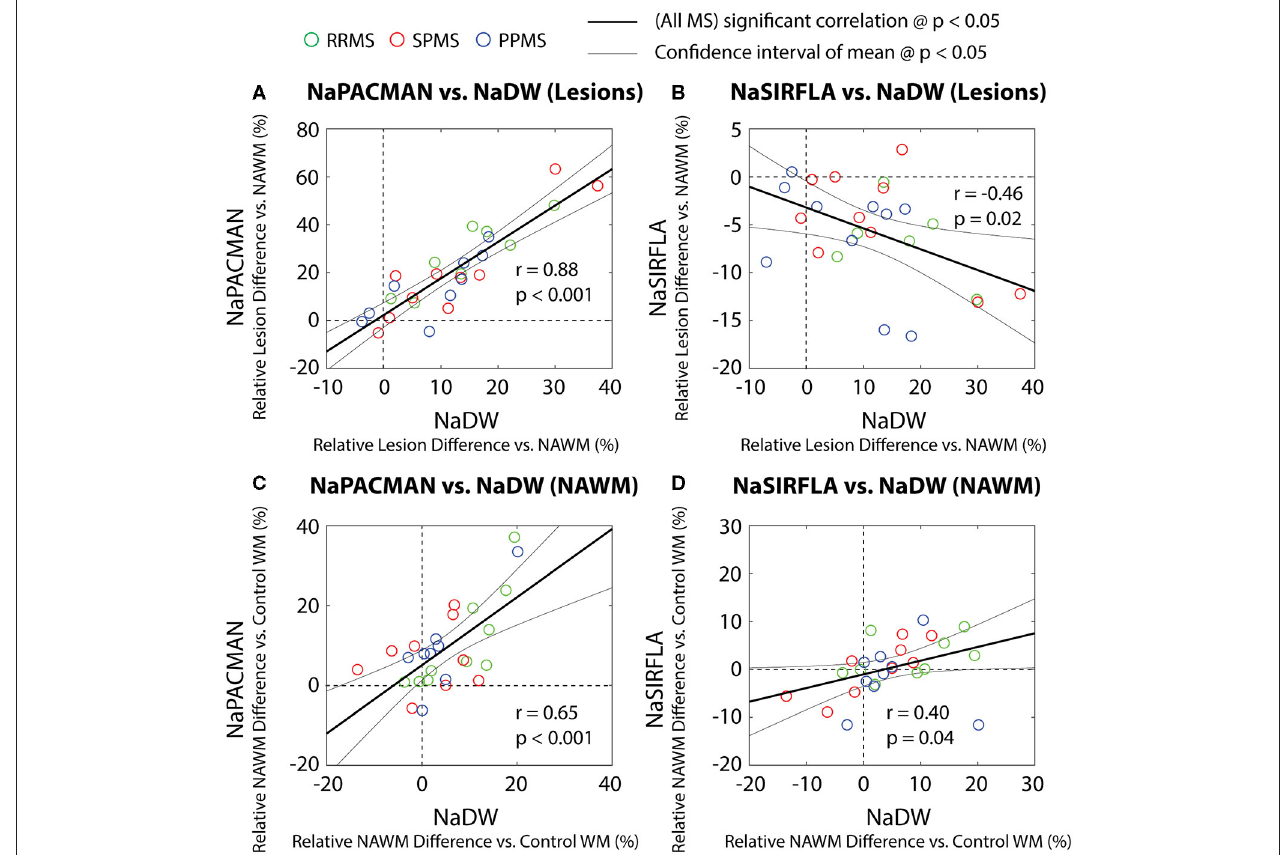
FIGURE 5 | Relaxation-weighted sequence correlations with NaDW (or TSC) for relative lesion intensity difference from directly comparably NAWM (in the same MS patient and WM region) (A,B) and relative NAWM difference from average control WM (C,D) for all 30MS participants (one symbol per patient). (A) Lesion intensity increase over directly comparable NAWM is positively correlated between NaPACMAN and NaDW with slope = 1.52 ± 0.33 showing a greater change for NaPACMAN. (B) However, lesion vs. NAWM is negatively correlated between NaSIRFLA and NaDW with slope = − 0.22 ± 0.18 (i.e., the more sodium TSC in lesions, the greater the signal loss on NaSIRFLA) and significant intercept offset of − 0.03 ± 0.03 ( p = 0.02). Note that for (A) the y-axis is 2 × the x-axis, while in (B) the y-axis is 0.5 × the x-axis. (C) NAWM intensity relative to average control WM is positively correlated between NaPACMAN and NaDW with slope = 0.85 ± 0.41 (less steep than lesions vs. NAWM) and significant intercept offset of 0.05 ± 0.04 ( p = 0.01). (D) NAWM vs. control WM is positively correlated between NaSIRFLA and NaDW with slope = 0.29 ± 0.27; this is opposite that seen for lesions relative to